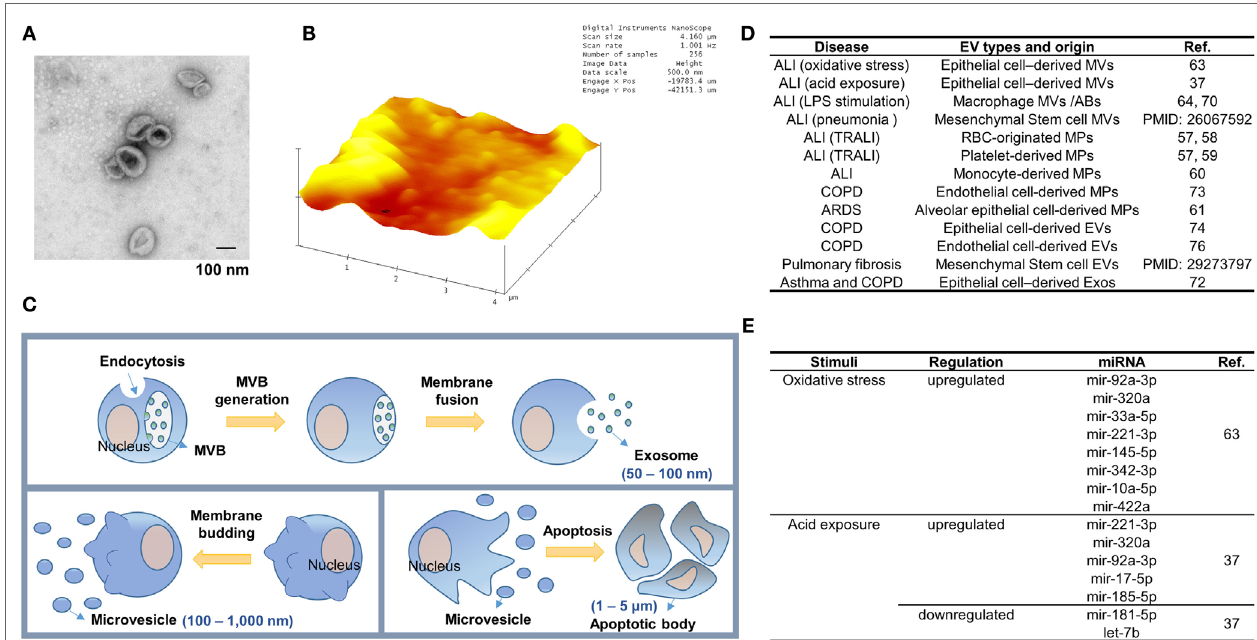
FiGURe 1 | Extracellular vesicle (EV) generation during lung inflammation. (A,B) Transmission electron microscopy (TEM)-based (A) and atomic force microscopy (AFM)-based (B) structure images of EVs derived from bronchoalveolar lavage fluid. EVs were fixed and dried on the formvar coated TEM grids (Ted Pella, Redding, CA, USA) and the cleaved mica sheets (Grade V-1, thickness 0.15 mm, size 15 × 15 mm) for TEM and AFM analysis, respectively. (C) Three main types of EVs. Exosome generation is initiated by membrane-endocytosis and inward-budding of the endosomal membranes to form multiple vesicular bodies (MVBs). Exosomes are then released when the MVBs are fused with the plasma membrane of the cells. Meanwhile, microvesicles (MVs) are formed by outward-budding of the plasma membrane. The size of MVs (100 nm–1 µm) is bigger than exosomes (50–100 nm) and their production is stimulated in various cell-stress conditions. Apoptotic bodies (ABs) are formed by membrane-blebbing of apoptotic cells. ABs are the largest EVs (1–5 µm) and contain nuclear fragments. (D) The type of EVs released during the development of lung inflammation and injury. (e) Epithelial MV-containing miRNAs altered in sterile